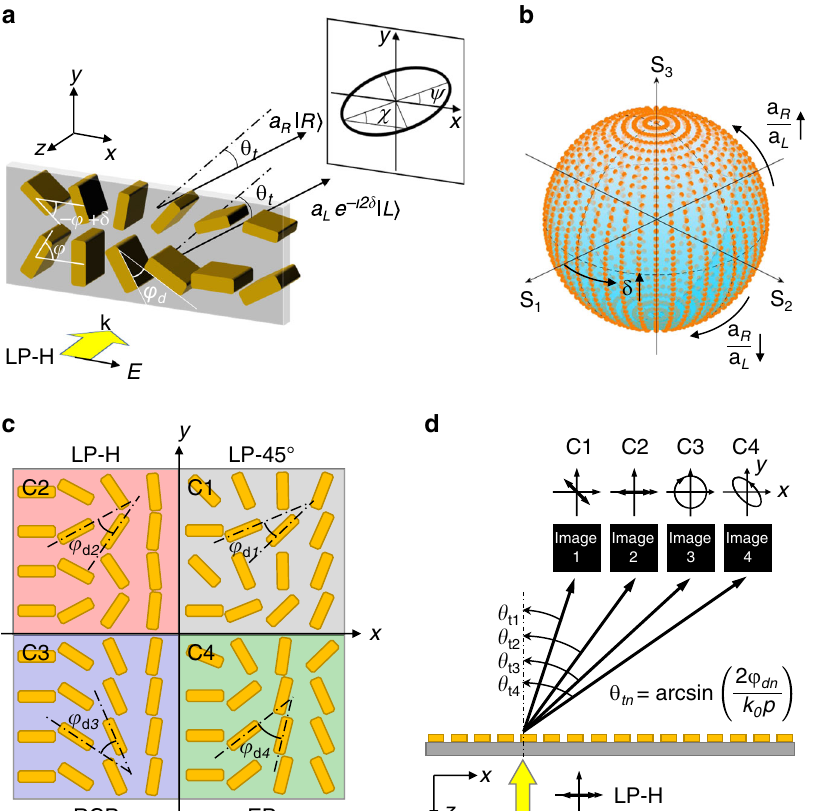
Fig. 1 Full-polarization-reconstruction and multi-directional meta-hologram. a Full-polarization-reconstruction through the superposition of two output CP beams with arbitrary phase and amplitude difference based on the same input LP beams. b Plotted Poincaré sphere covered full polarization with phase difference α from – π to π and amplitude a R and a L from 0 to 1. c Four subpixels of pixelated de fl ectors (labeled as C1, C2, C3, C4) representing to four SoP (LP-45°, LP-H, RCP, EP) are placed into one super-pixel to share the same aperture. d By encoding the holographic phase pro fi le into the four subpixels array independently, multi-directional holographic images with different SoP are displayed in the direction of θ tn ¼ arcsin 2 φ dn k